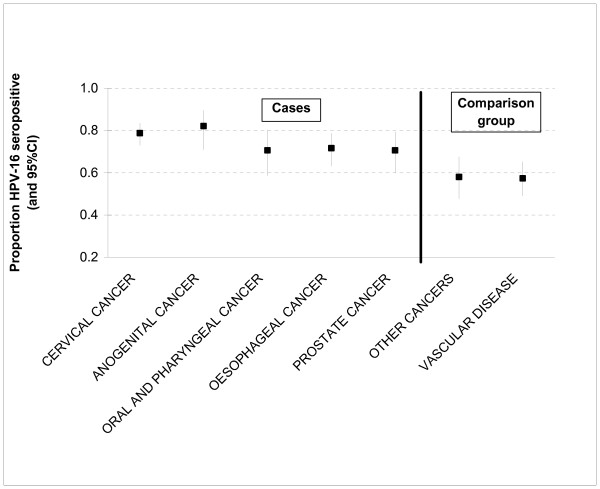
Adjusted proportions seropositive for HPV-16 IgG among the cases and comparison group.